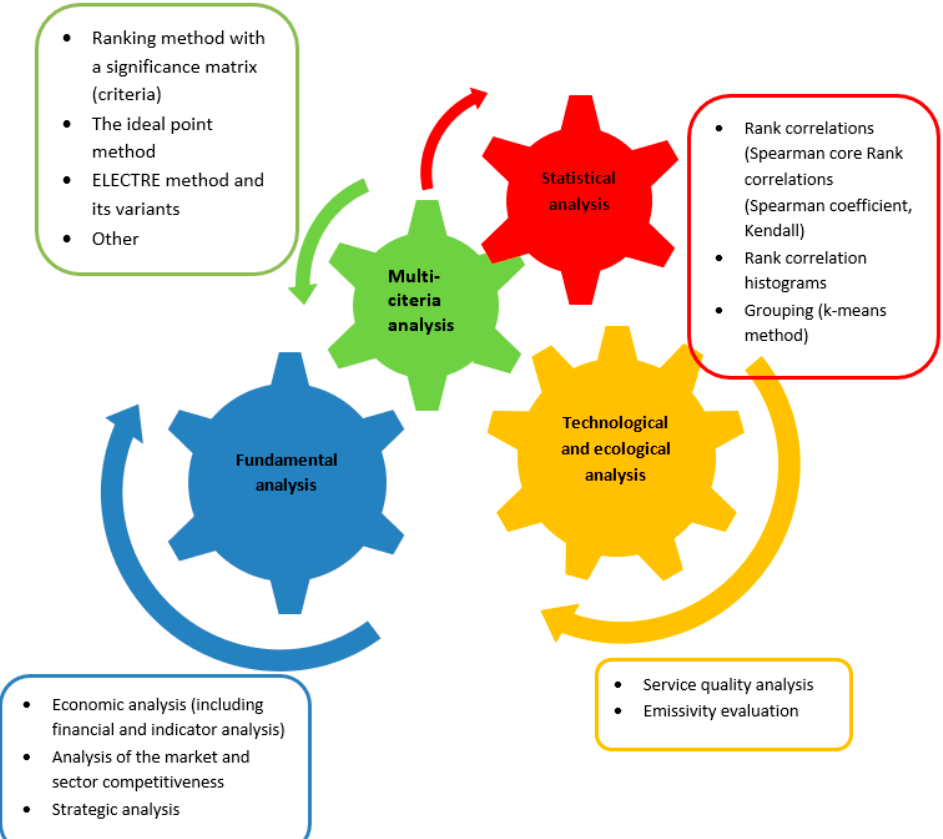
Figure 5. Methods and tools for evaluating companies from the LSP sector.